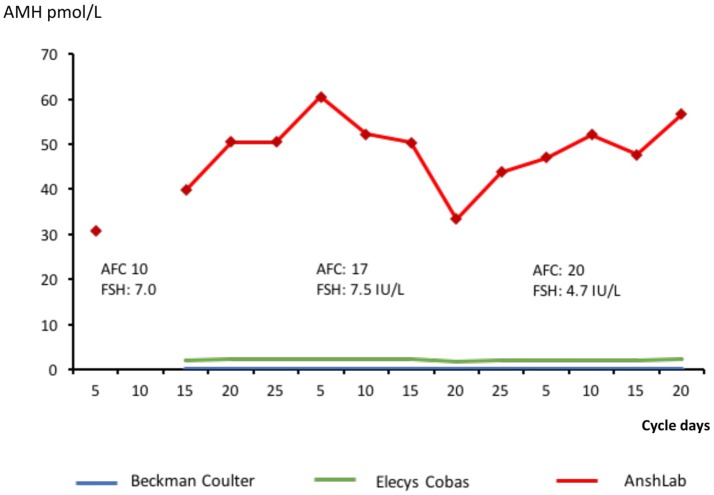
A case of significant discrepancy between assays. The Beckman Coulter assay was not able to detect AMH and all readings have the value zero. Antral follicle count and FSH recordings are added.